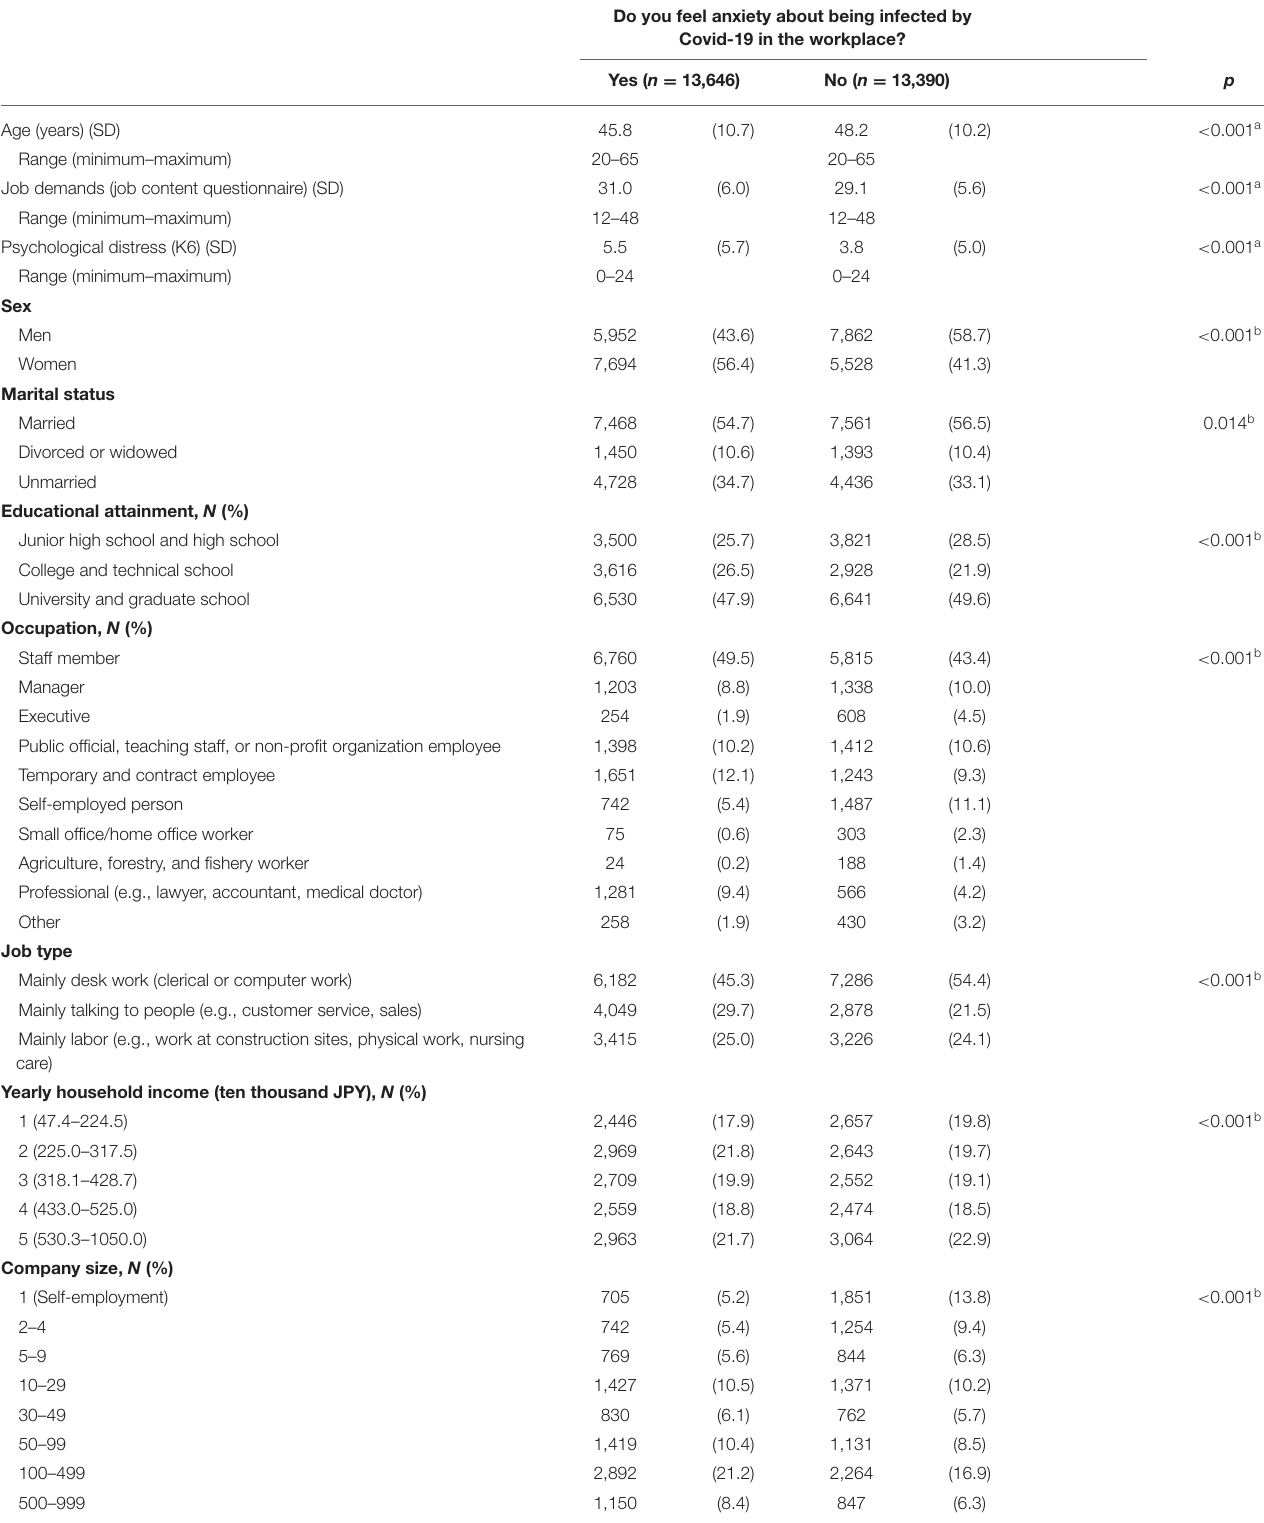
TABLE 1 | Participant characteristics ( n =